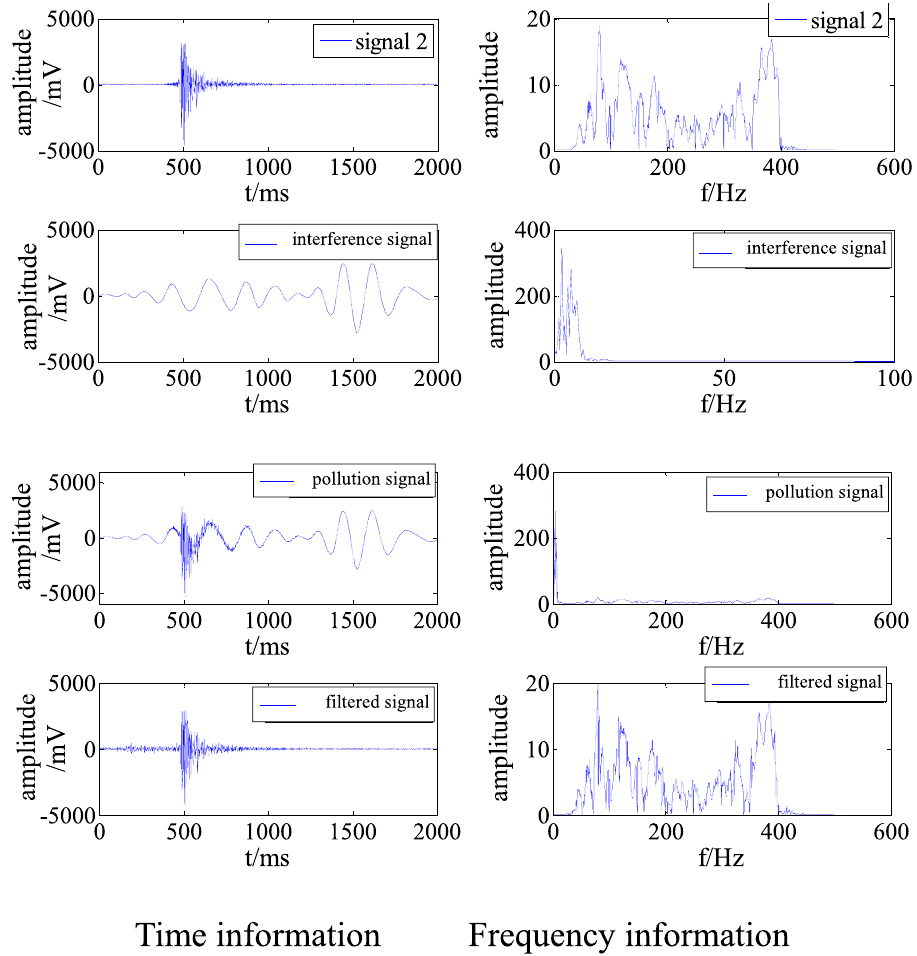
Figure 6. Time and frequency information of a signal polluted by multi-frequency interference before and after filtering.